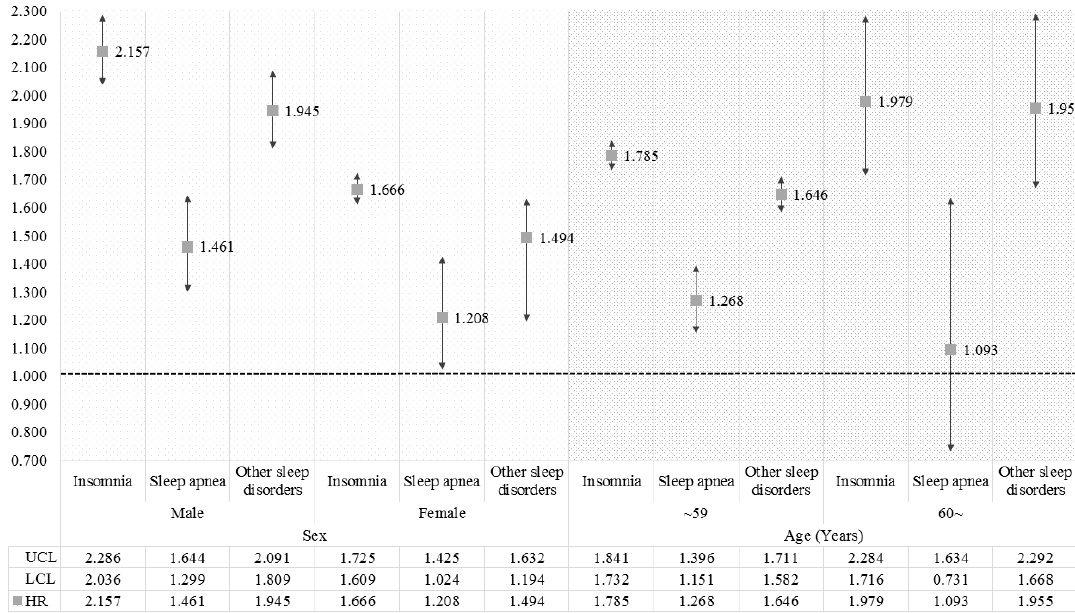
Figure 2. The results of sub-group analysis for survival analysis according to sex and age. The HR was calculated by survival analysis to investigate the association between sleep disorder and migraine. Results were considered to be statistically significant if each bar marked to SD did not reach the cut-off line of 1.000.